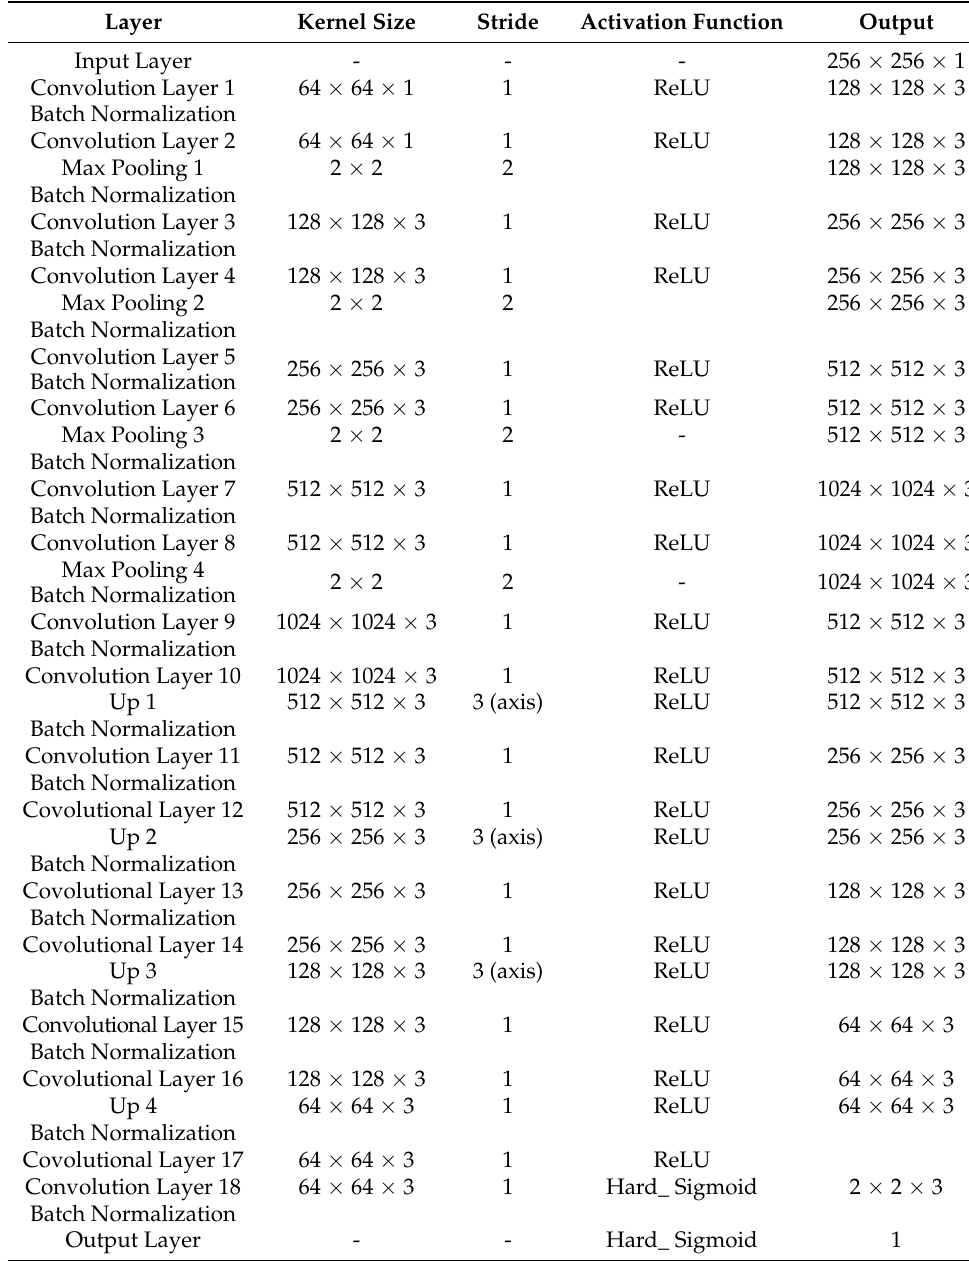
Table 4. U-Net Detail